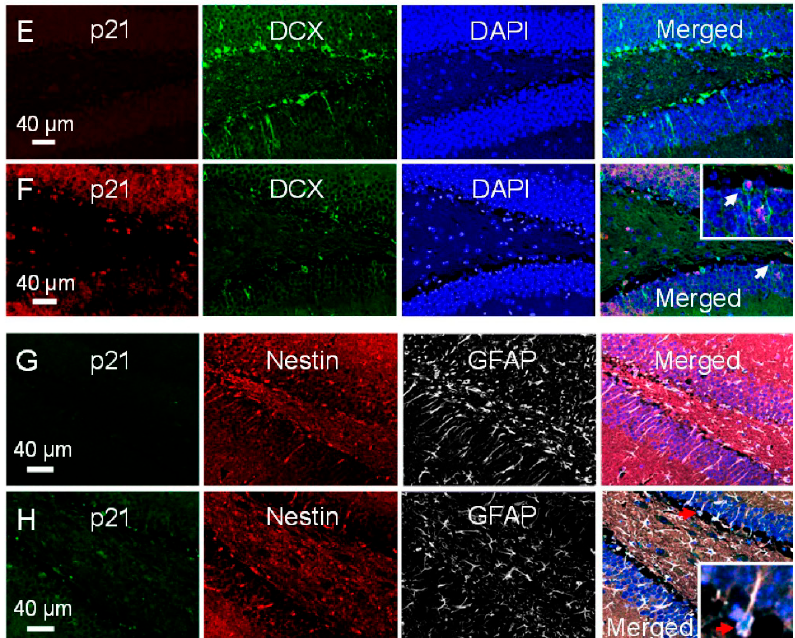
Figure 7. There is upregulation of p53 and p21 in dentate gyrus after irradiation. There is no evidence for p53 immunoreactivity in dentate gyrus of non-irradiated mice ( A ); after irradiation, p53 nuclear immunoreactivity is seen in dentate gyrus at 8 h (( B ), p53, red; DCX, green; DAPI, blue), and some p53 immunoreactive cells are DCX positive (( B ), merged, arrow, inset); cells immunoreactive for p53 do not express nestin or GFAP (( C ), control; ( D ), 5 Gy; p53, green; nestin, red; GFAP, white; DAPI, blue; arrows); there is no p21 immunoreactivity observed in non-irradiated dentate gyrus; increase in p21 nuclear immunoreactivity is seen at 8 h after irradiation (( E ), 0 Gy; ( F ), 5 Gy; p21, red; DCX, green; DAPI, blue; ( G ); 0 Gy; ( H ), 5 Gy, p21, green; nestin, red; GFAP, white; DAPI, blue). Some cells immunoreactive for p21 express DCX (( F ), merged, arrow, inset), and some express both nestin and GFAP (( H ), merged, arrow, inset).